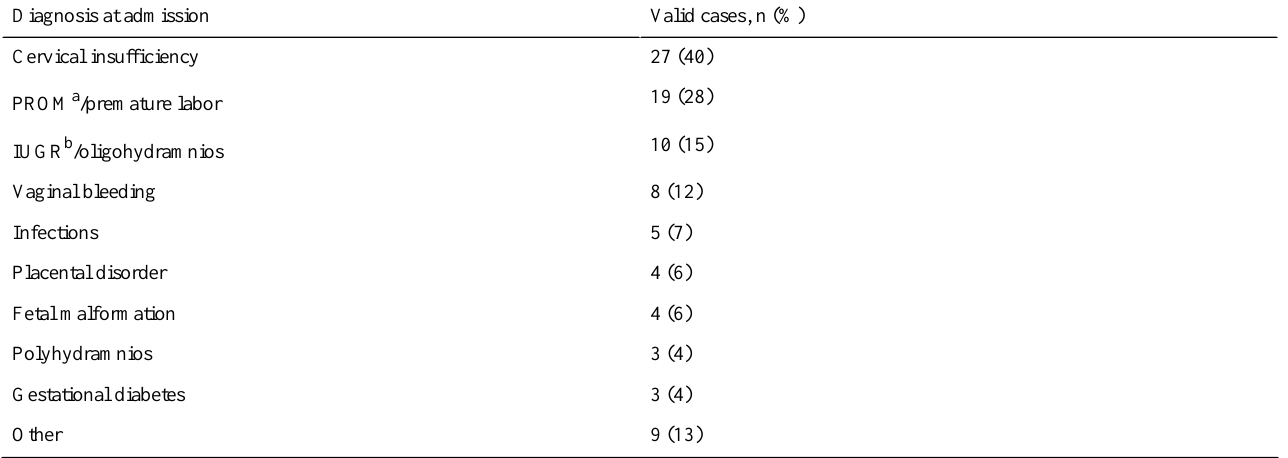
Table 3. Cases diagnosed at admission for hospitalization (N=67, multiple answers